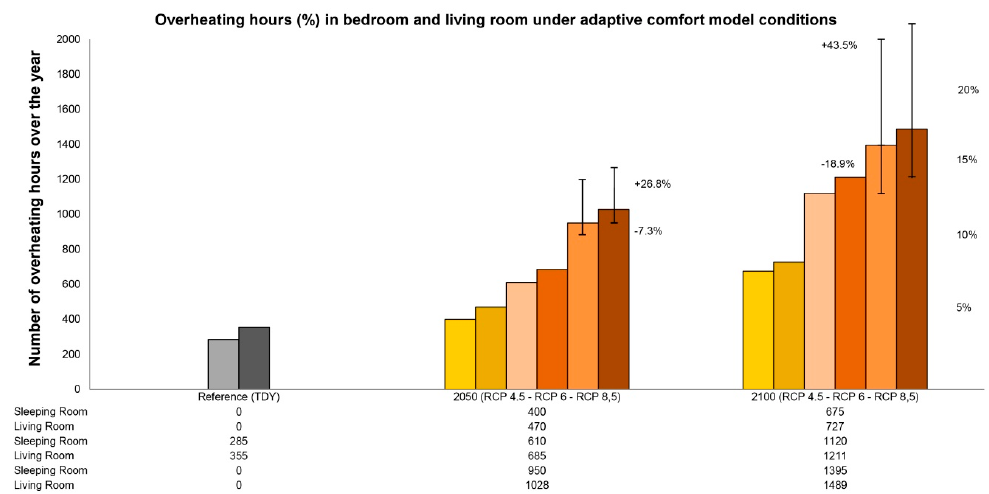
Figure 6. Results of climate and building thermal performance modeling under the European adaptive comfort model.